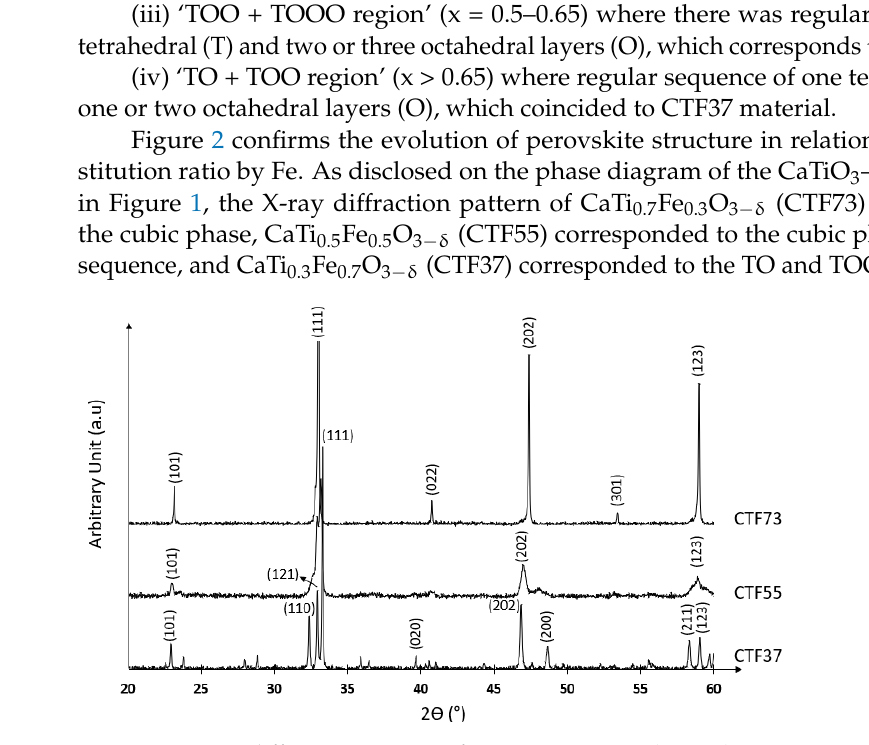
Figure 2. X-ray diffraction pattern of CaTi 0.7 Fe 0.3 O 3−δ (CTF73), CaTi 0.5 Fe 0.5 O 3−δ (CTF55), and CaTi 0.3 Fe 0.7 O 3−δ (CTF37) of pellets.